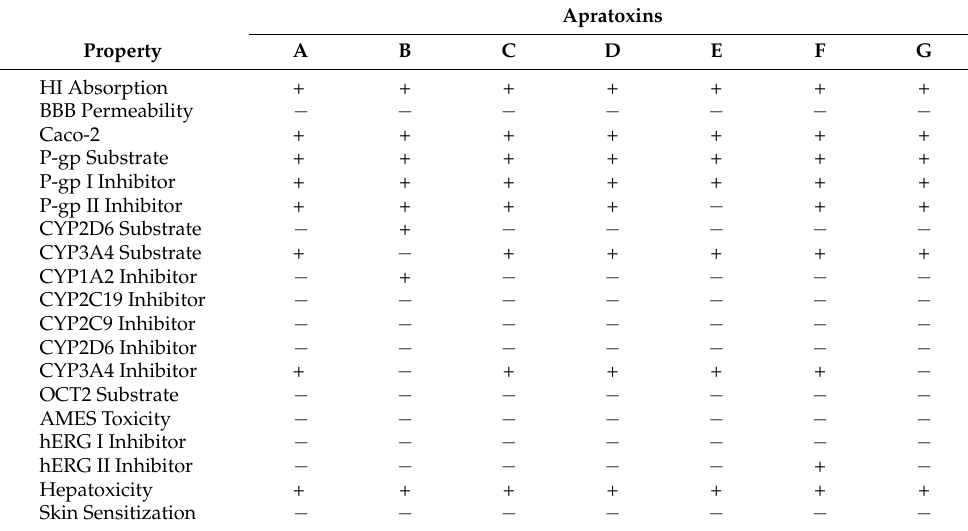
Table 5. Computed ADMET pharmacokinetic profiles of the Apratoxins A–G family of marine